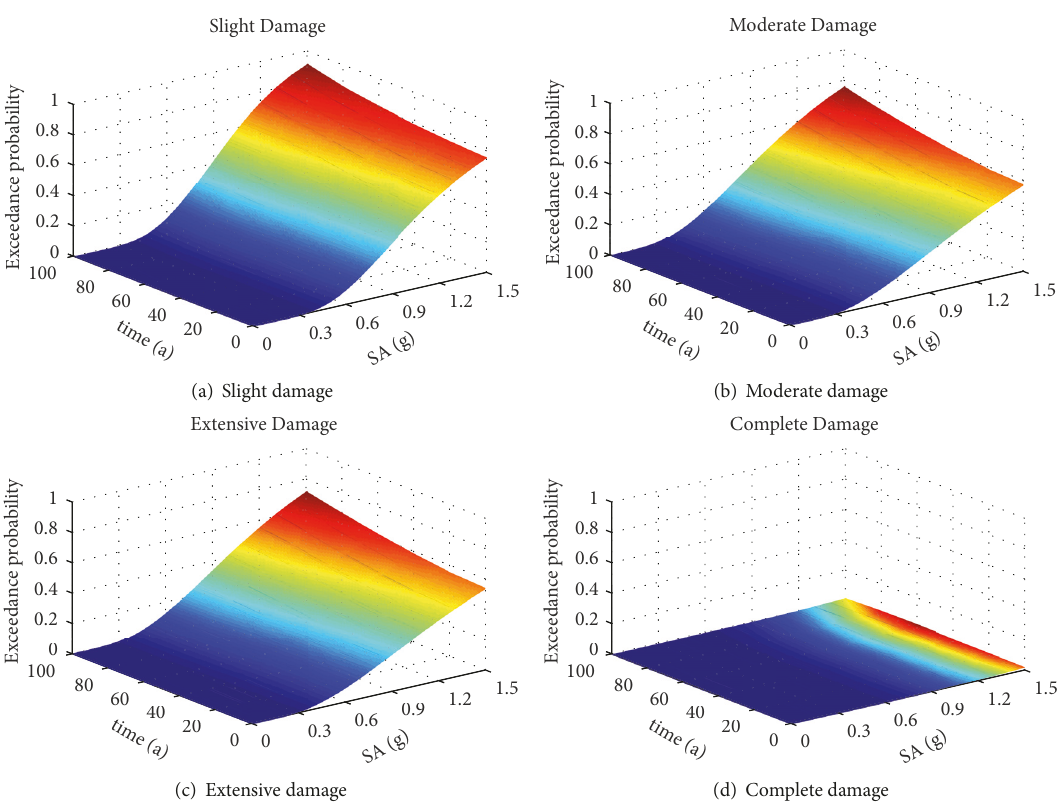
Figure 13: The vulnerability surfaces of 3 # pier under different damage